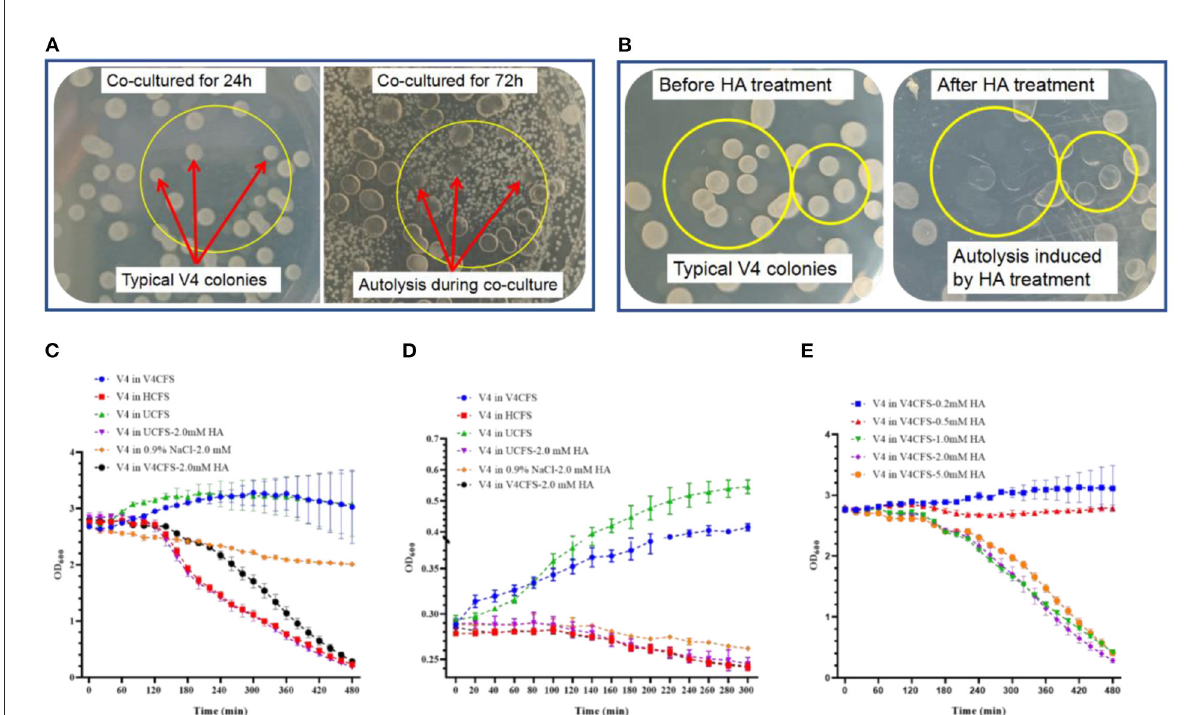
FIGURE3 The effect of HO-1 co-culture or treatment with HA on the colony morphology and survival kinetics of B. velezensis V4. (A) Changing appearance of B. velezensis V4 colonies during co-culture with A. ammonioxydans HO-1. Red arrows inside yellow circles indicate typical B. velezensis V4 colonies before significant A. ammonioxydans HO-1 growth at 24h (on the left) and to the same colonies after the growth of A. ammonioxydans HO-1 caused autolysis at 72h (right). (B) Typical B. velezensis V4 colonies before the treatment with HA (left) and the same plaques following autolysis after HA treatment (right). (C) Survival kinetics of B. velezensis V4 (high initial population density, OD 600 = 3.0) in V4CFS (as control), HCFS, UCFS, UCFS-2.0mM HA, 0.9% NaCl-2.0mM HA, V4CFS-2.0mM HA. (D) Survival kinetics of B. velezensis V4 (low initial population density, OD 600 = 0.3) in V4CFS (as control), HCFS, UCFS, UCFS-2.0mM HA, 0.9% NaCl-2.0mM HA, V4CFS-2.0mM HA. (E) Survival kinetics of B. velezensis V4 in V4CFS containing 0.2, 0.5, 1.0, 2.0, and 5.0mM HA. Error bars represent standard deviations based on three